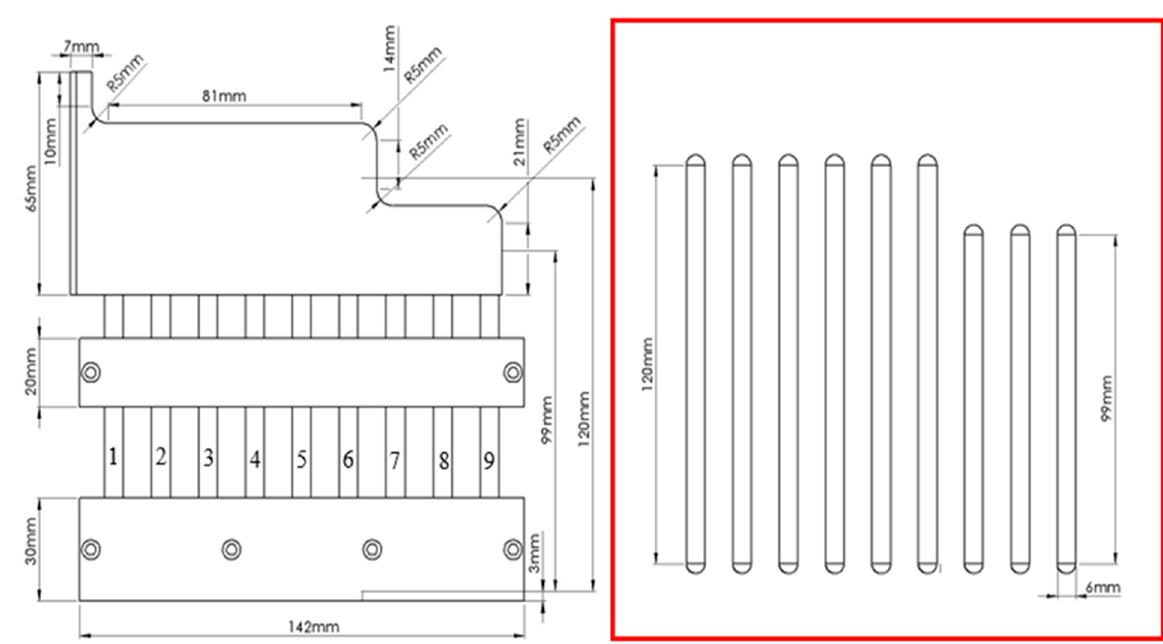
Figure 6. Configuration of Type III cold plate.